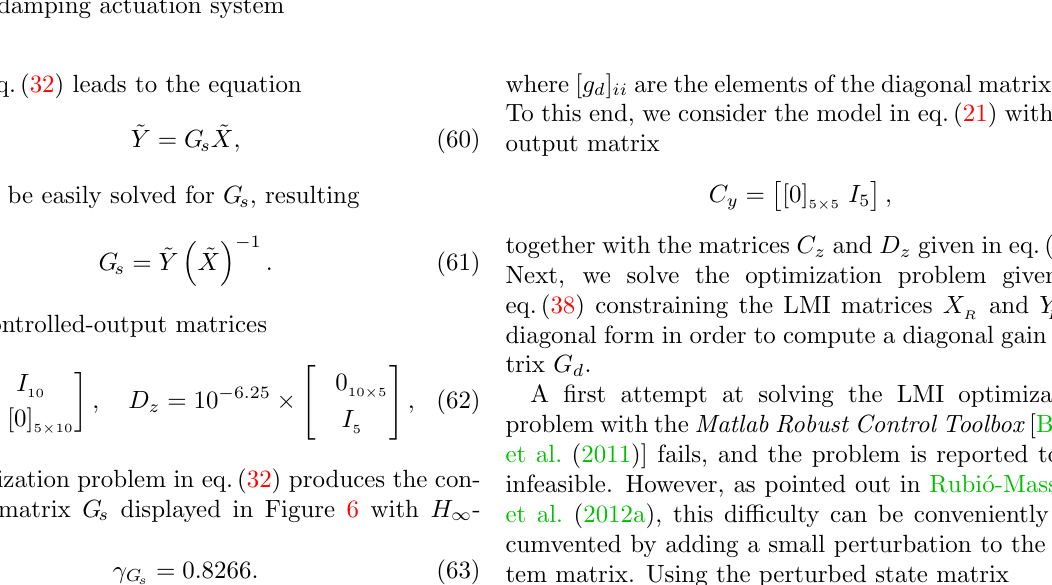
Figure 7: Five-degree-of-freedom mass-spring-damper representation of the five-story building with passive- damping actuation